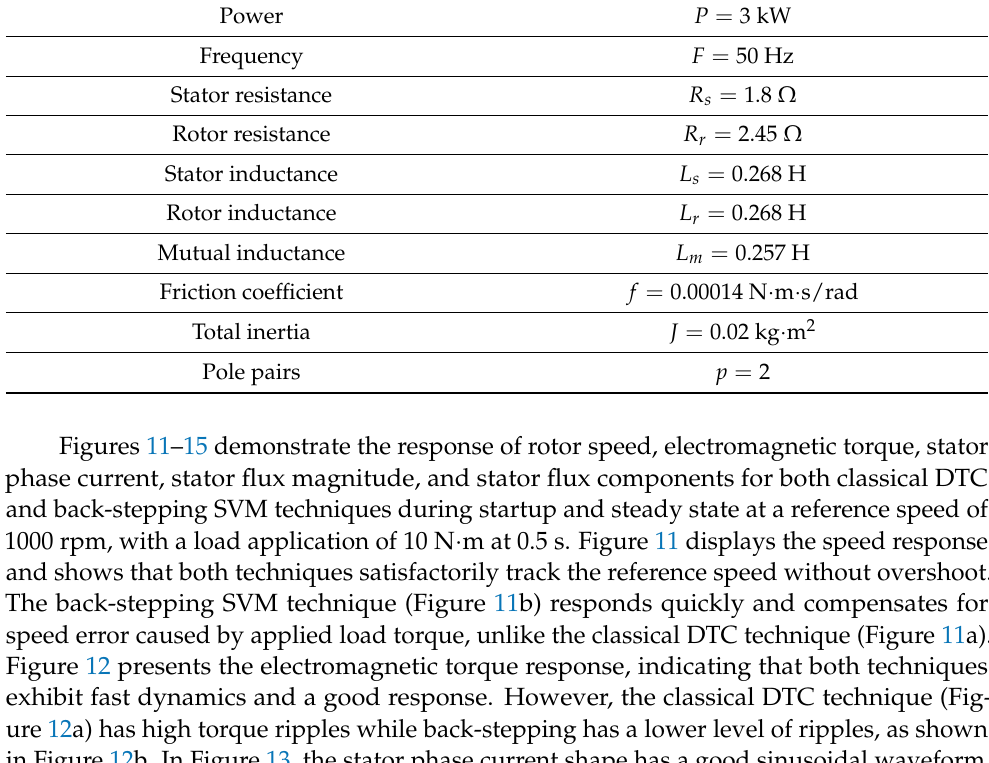
Table 2. Parameters of the induction motor.